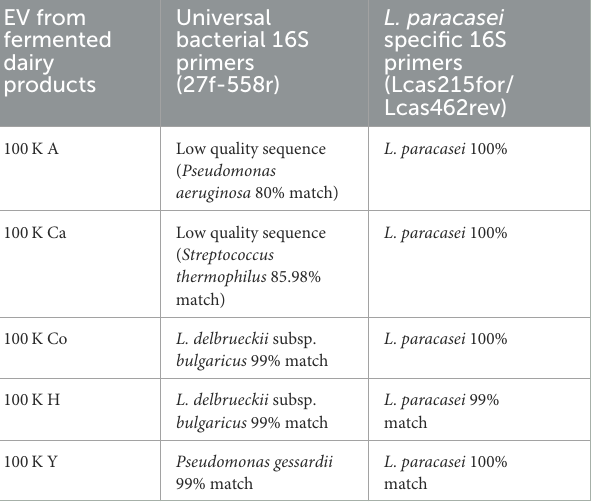
TABLE 3 EV size distribution, determined by DLS, of different milk samples with added L. paracasei EV recovered after 15, 33, and 100K